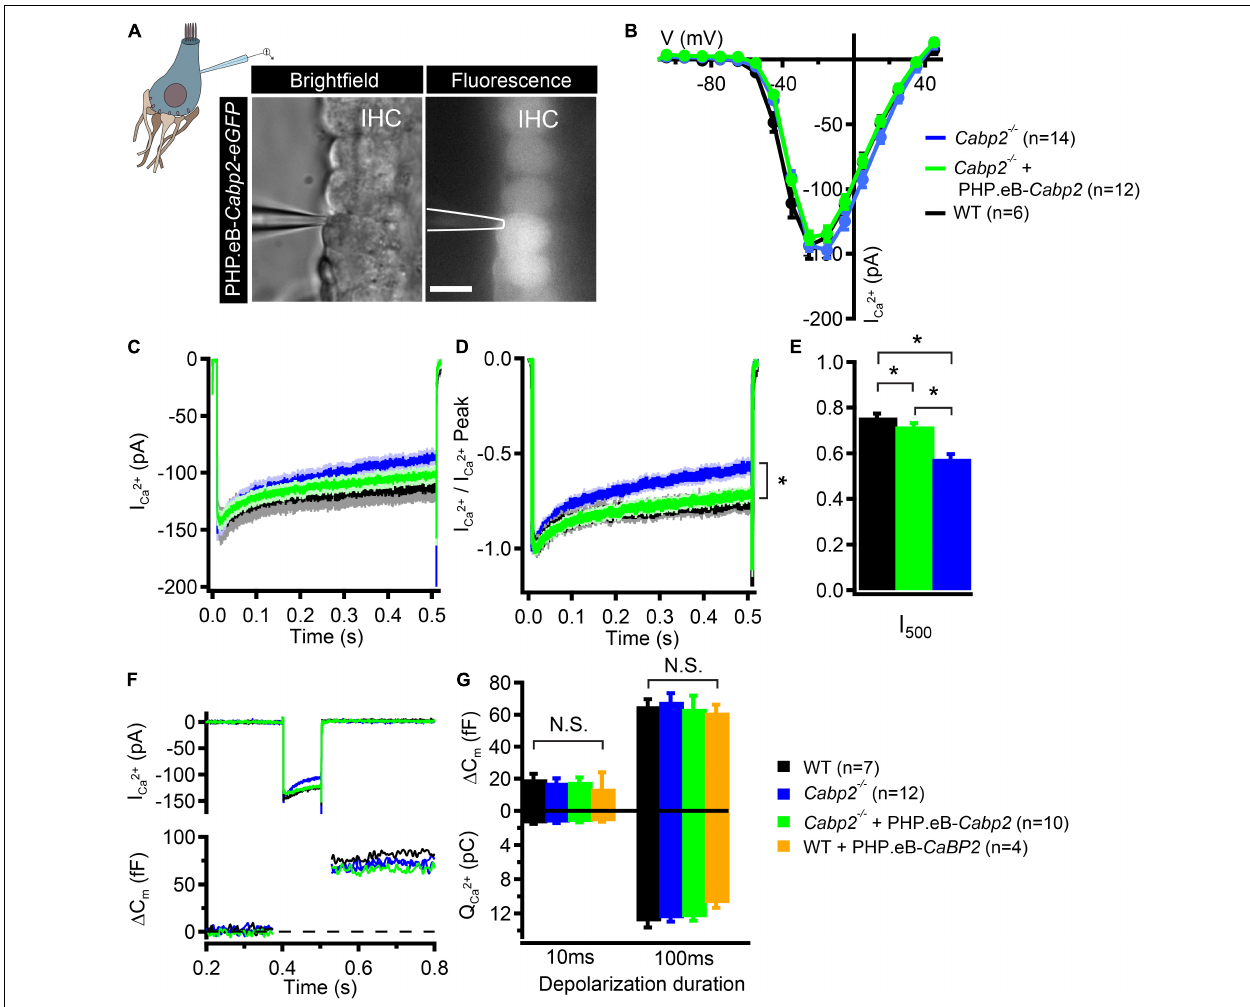
FIGURE 4 | PHP.eB-calcium-binding protein 2 ( Cabp2 )-mediated restoration of IHC Ca V 1.3 channel inactivation kinetics. (A) Representative brightfield and corresponding fluorescence image showing eGFP-expressing IHCs of a 5-week old Cabp2 − / − animal injected with PHP.eB- Cabp2 . Scale bar = 10 µ m.